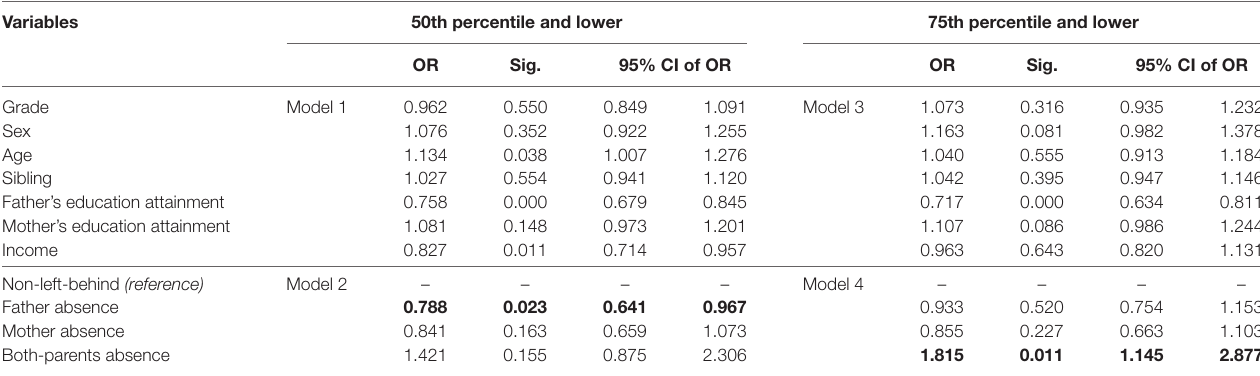
TaBle 2 | Logistic regression models for predicting lower scores in Chinese